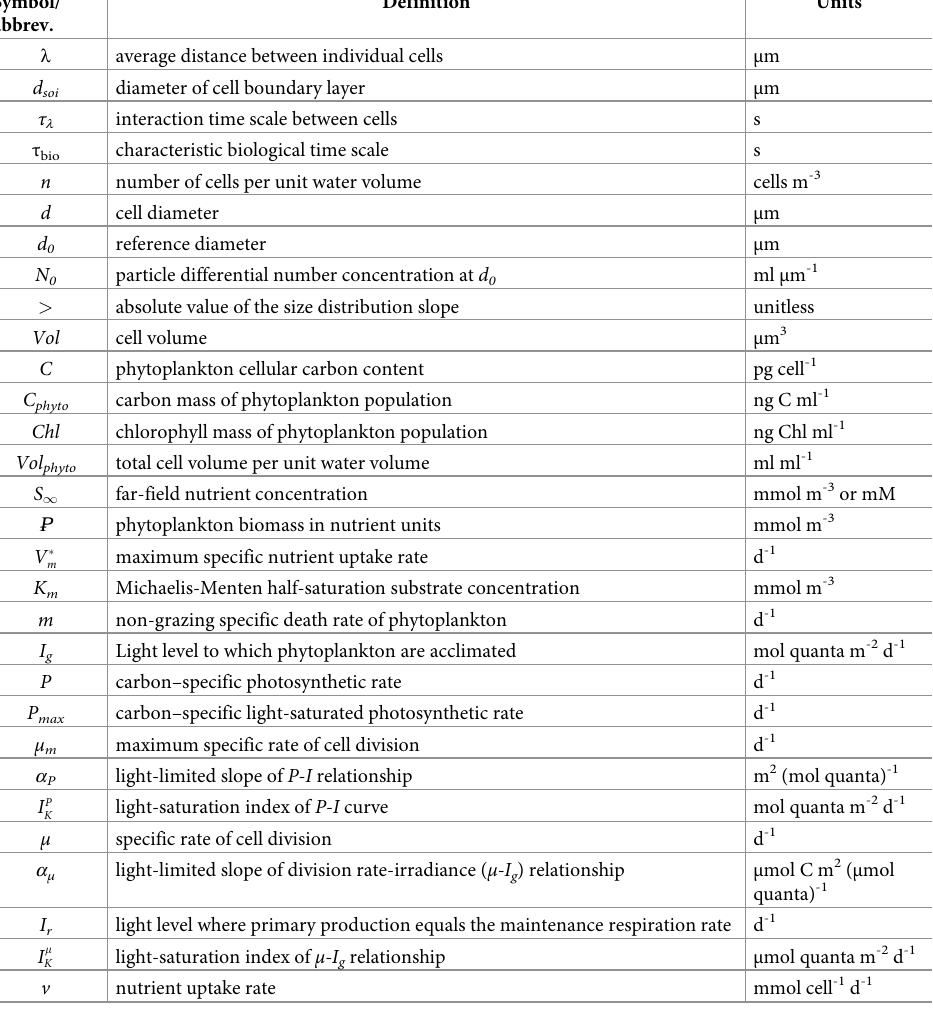
Table 1. Symbols/abbreviations, definitions, and units (in order of appearance in manuscript). Symbol/ Definition Units abbrev. λ average distance between individual cells μ